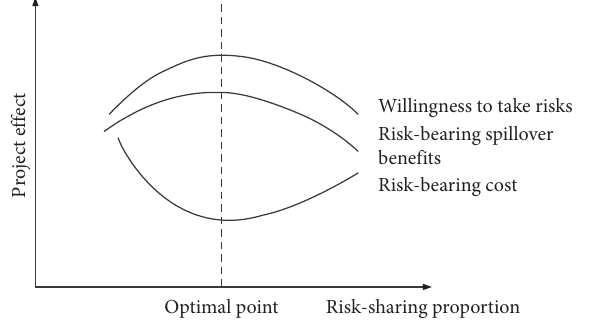
Figure 3: Effect of risk